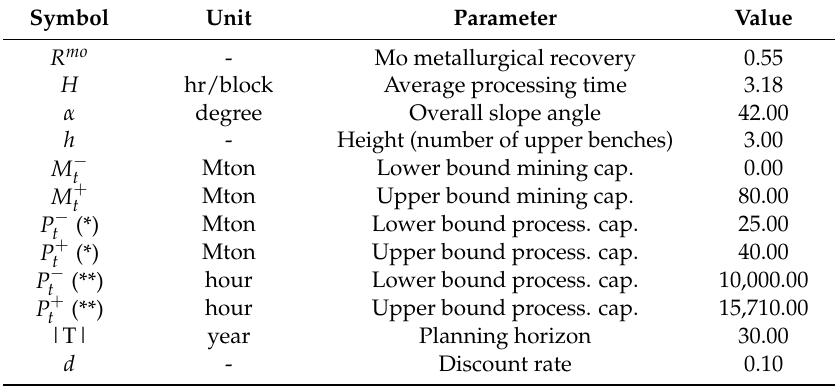
Table 4. Summary of technical parameters for case study. Bounds on processing capacity to be considered: (*) scheduling Schemes 2 and 3; and (**) scheduling Scheme 4.